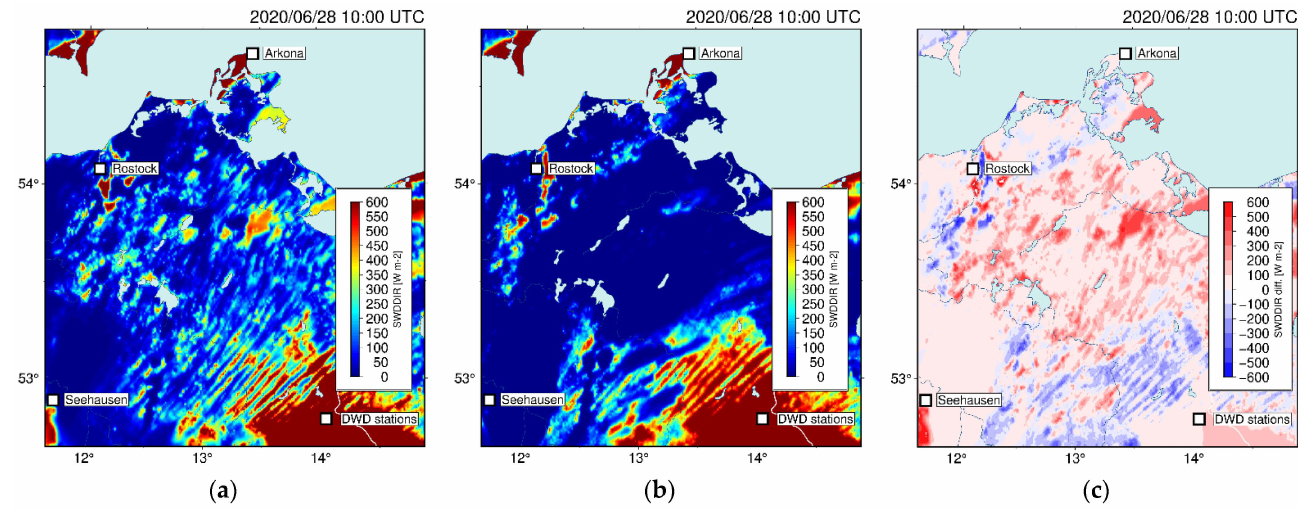
Figure 11. Shortwave surface downward direct irradiance ( SWDDIR ) forecast for 28 June 2020 at 10:00 for: ( a ) WRF-DUDIA; ( b ) WRF-RRTMG; and ( c ) their differences.